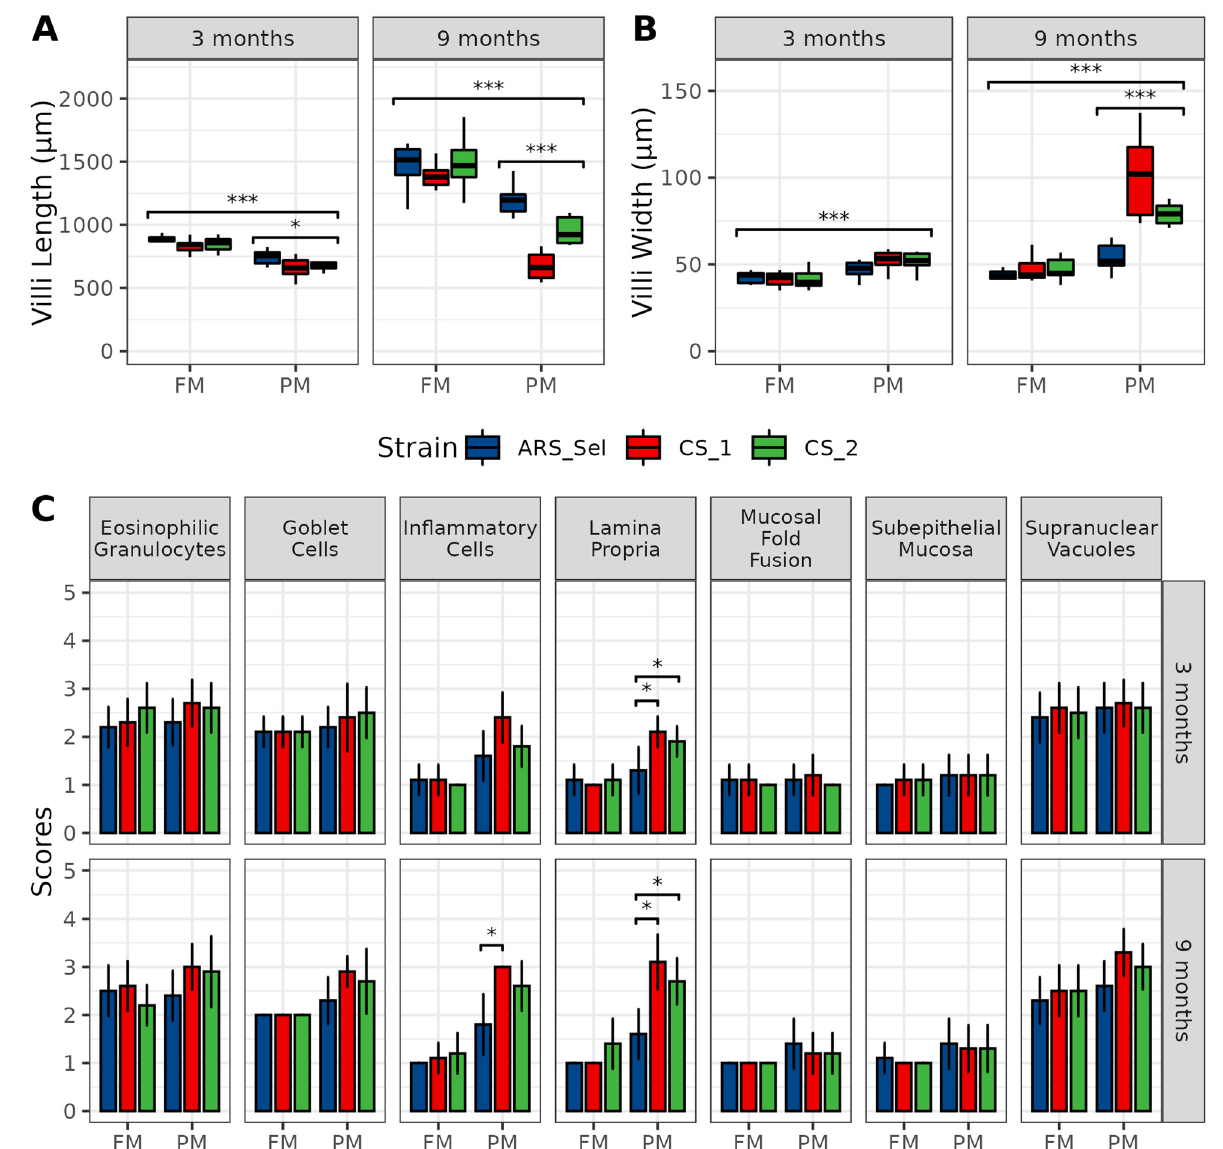
Figure 1. Results from histological analyses of distal intestinal samples from one selected (ARS- Sel ) and two commercial strains (CS-1 & CS-2) of rainbow trout fed either fishmeal- or plantmeal-based diets at 3 and 9 months. Continuous data on intestinal villi length ( A ) and width ( B ) were quantified by imaging software and tested by Kruskal–Wallis to detected difference between diets across all strains, as well as strain differences within diets. Ordinal scoring data (ranked 1–5) for other histological metrics were analyzed using a paired Wilcoxon rank-sum test comparing both commercial strains to the ARS_Sel strain within diet and timepoint, with a Holm–Bonferroni multiple comparisons correction ( C ). * p ≤ 0.05, *** p ≤ 0.001.